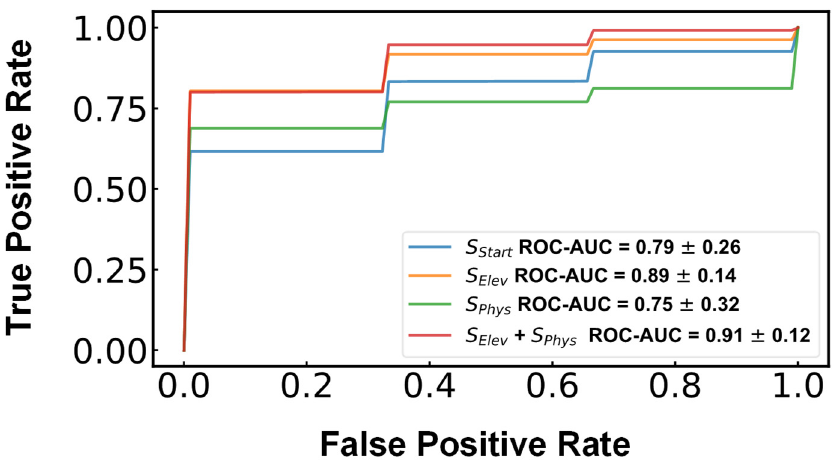
Figure 7. The mean ROC curves of each model are plotted for comparison. The curves and ROC-AUC values are the averaged result of 300 iterations of each model each with a randomized 70:30 training/testing split.